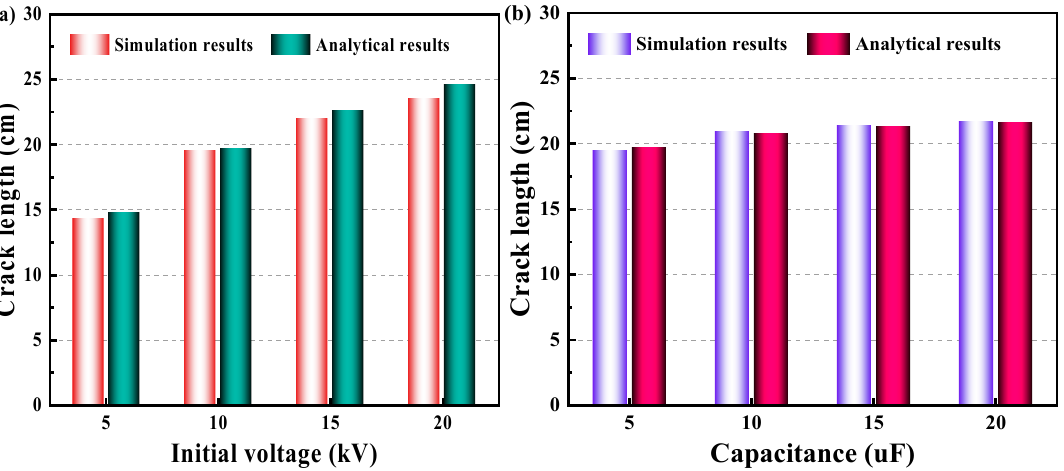
Figure 15. Validation of this paper’s results for crack length under different ( a ) initial voltage and ( b ) capacitance by using simulation approach and analytical approach, respectively. ( b ) capacitance by using simulation approach and analytical approach,